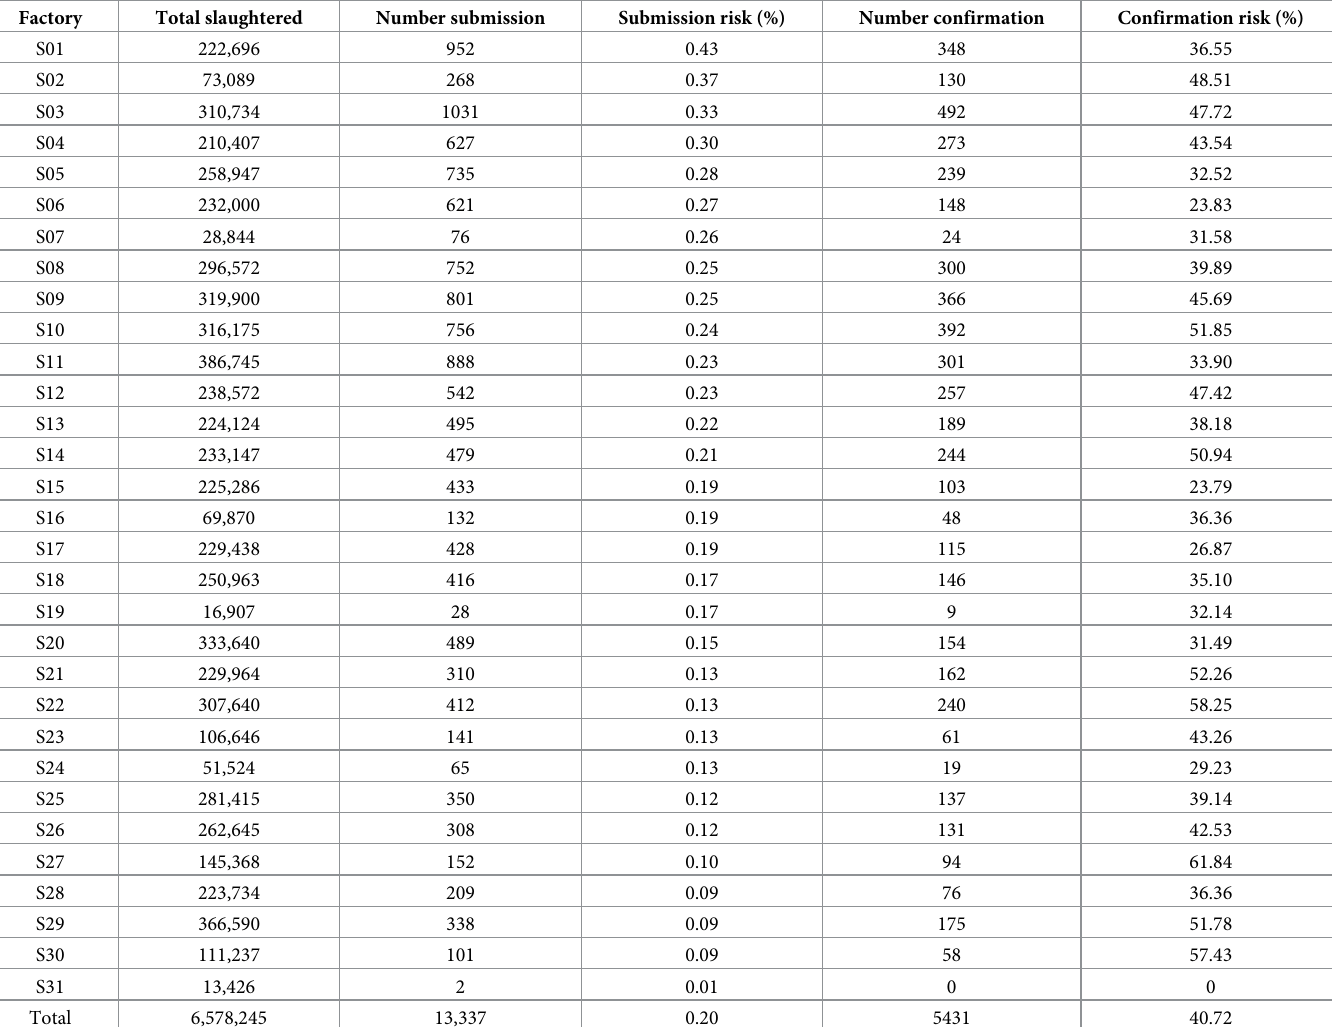
Table 2. Distribution of animals slaughtered, submission risk, and confirmation risk of submitted lesions over factories included in the analysis.